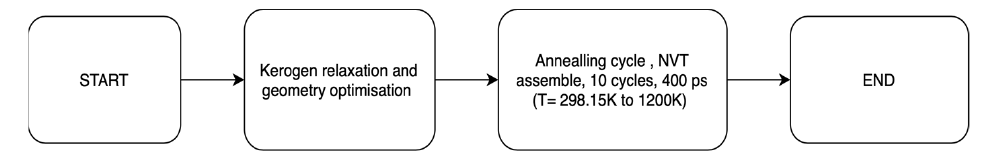
Figure 3. Kerogen molecules’ geometry optimization and annealing process.